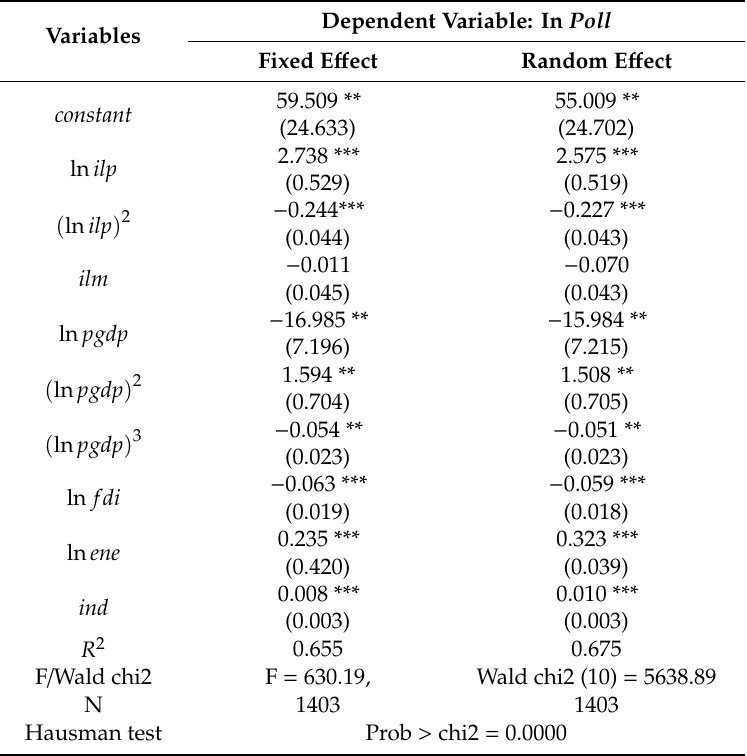
Table 2. Estimation results of full sample